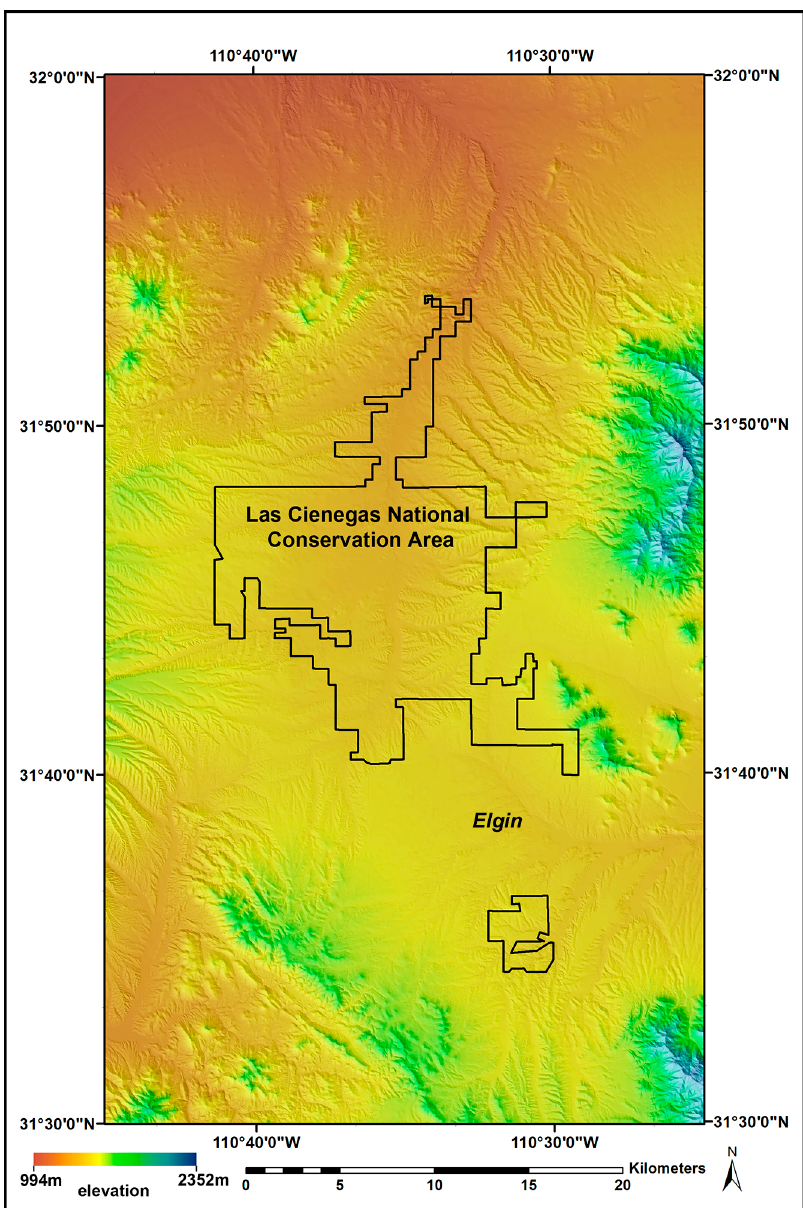
Figure 5. The region of the Landsat-based development and application of the Normalized Difference Phenometric Index (NDPI), including the boundaries of the Las Cienegas National Conservation Area and the location of community of Elgin, Arizona. The location of this area within the larger MODIS study area is shown in Figure 2.